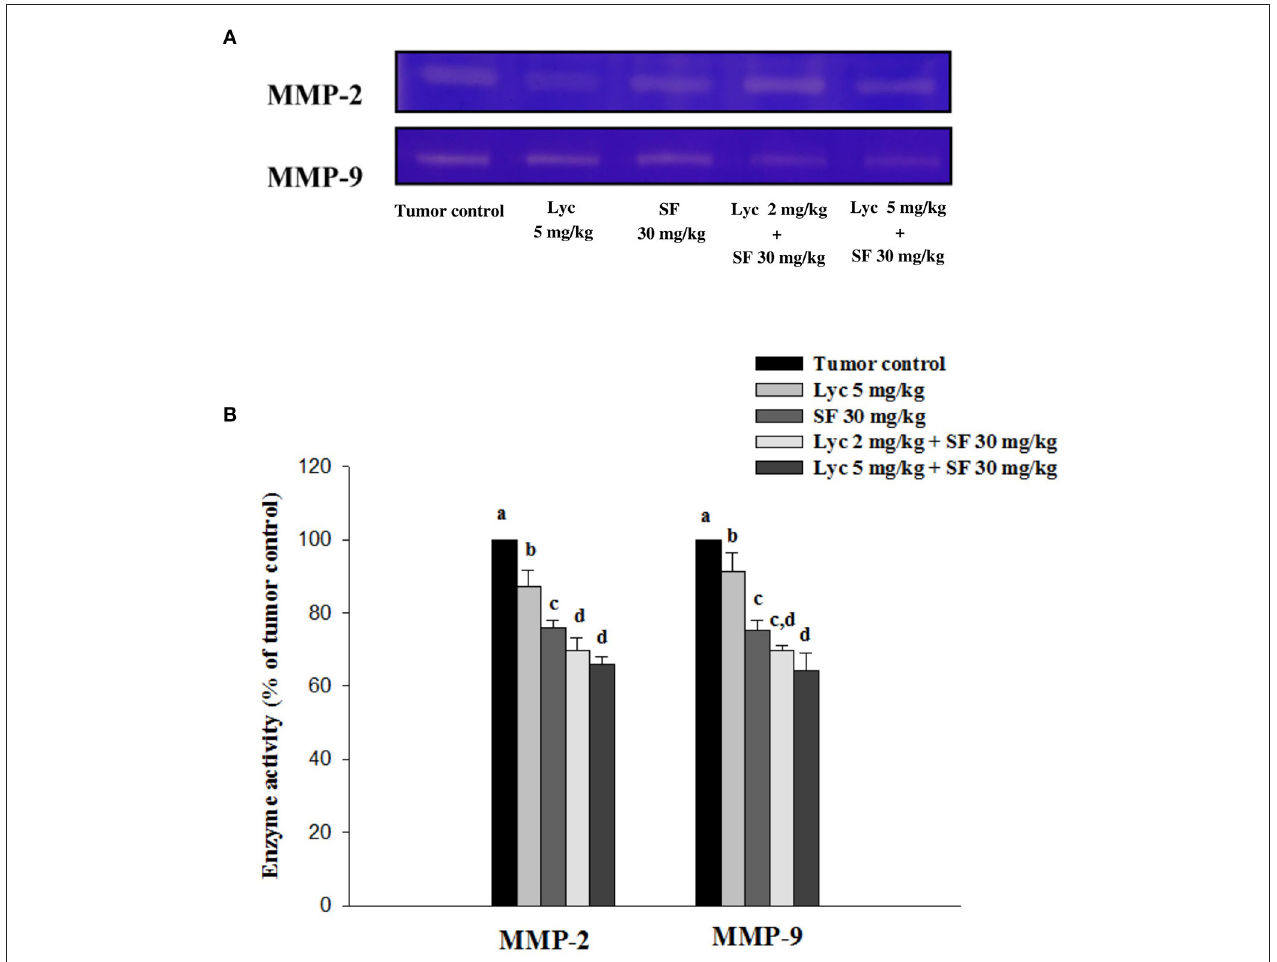
FIGURE 4 | Effects of lycopene (Lyc) alone, sorafenib (SF) alone, or their combination on MMP-2 and MMP-9 activities in plasma of the C57BL/6 mice xenografted LLC cells. Nine days after the tumor cell injection, mice were orally supplemented with SF (30 mg/kg) daily, Lyc (5 mg/kg) twice per week or the combined treatment (mice were supplemented with SF (30 mg/kg) daily, and Lyc (2 and 5 mg/kg) twice per week) for 28 days. (A) Zymography analysis of MMP-2 and MMP-9 activities. (B) Quantitative results of zymography of MMP-2 and MMP-9 activities. Data are means ± SD, n = 7 – 8; values not sharing an alphabetic letter are significantly different ( P <